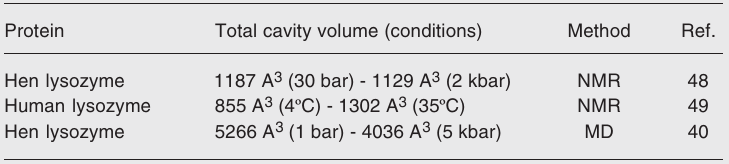
Table 1. Effects of pressure and temperature on the total volume of the cavities in proteins as obtained from NMR and molecular dynamics (MD) simulations. Protein Total cavity volume (conditions) Method